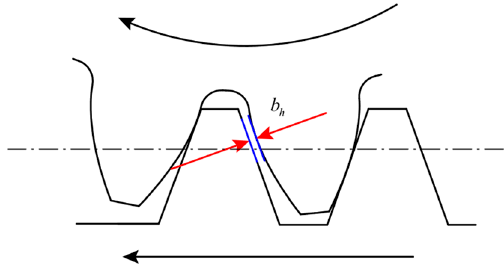
Figure 18. Schematic diagram of backlash.